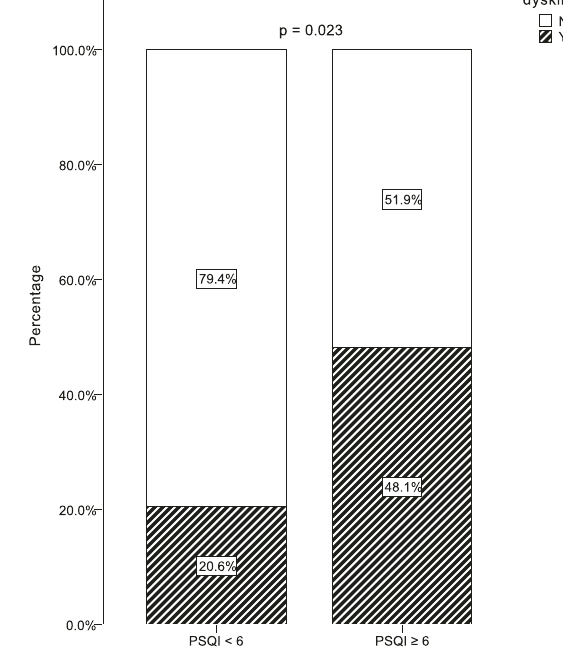
Fig. 2 Incidence of dyskinesia at the end of follow-up. PSQI, Pittsburgh Sleep Quality